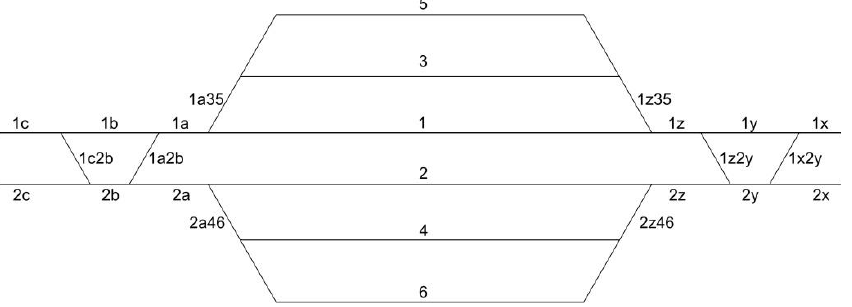
Figure 10. Graphical representation in Maple of the digraph corresponding to the connectivity of the track layout diagram of Figure 9 (the direction considered is from right to left). The coordinates of the vertices of the digraph were manually introduced in order for the plot of the graph to re- semble the shape of the railway station. Unfortunately, the Estaciones package cannot handle all the “ s pecial” turnouts (only the double-slip turnout). Let us consider afterwards, for instance, a scissors crossover. 2.3. Unsuccessful Attempts to Handle a Scissors Crossover First attempt: the crossing in the scissors crossing is represented by two directed arcs: (1y,2z) and (2y,1z) (Figure 11). Figure 11. Graphical representation of the first attempt to codify a scissors crossing. The connectivity of the scissors crossing is correctly represented in the digraph; however, there is no way to detect whether the two routes intersect or not at the crossing.